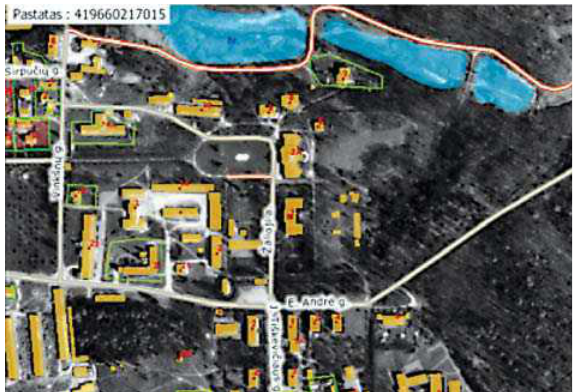
Fig 3. Orthophoto plan of Trakų Vokė manor homestead (1996)